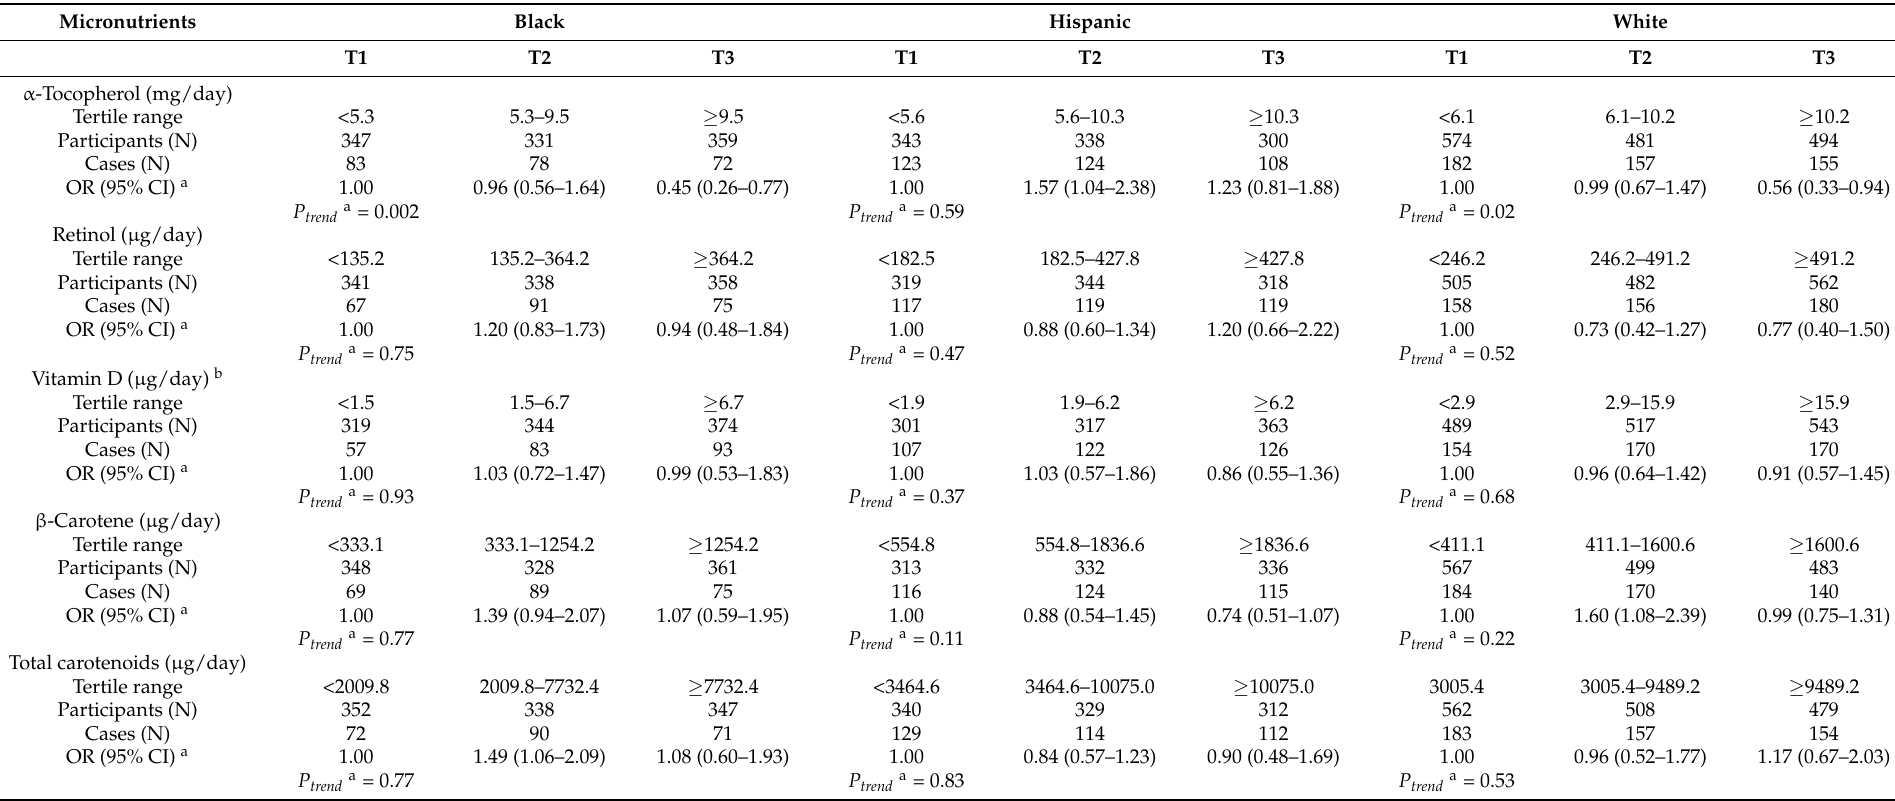
Table 3. Race/Ethnicity-Specific Odds Ratio and 95% Confidence Interval for Hepatic Steatosis by Tertles (T1-T3) of Dietary Micronutrients. Micronutrients